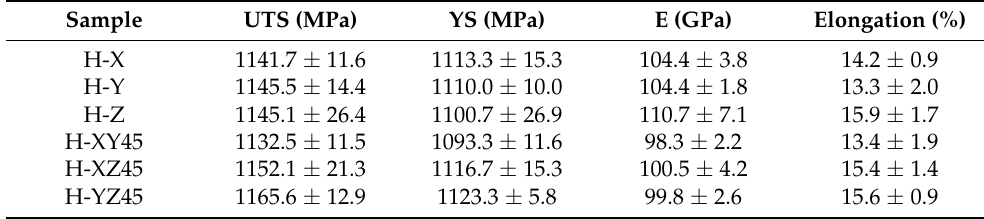
Figure 4. ( a ) Engineering stress–strain curves of aged Ti-55511 alloys. ( b ) The variations of the UTS, the YS, and the elongation of aged samples. Table 4. The mechanical properties of aged Ti-55511 alloys.